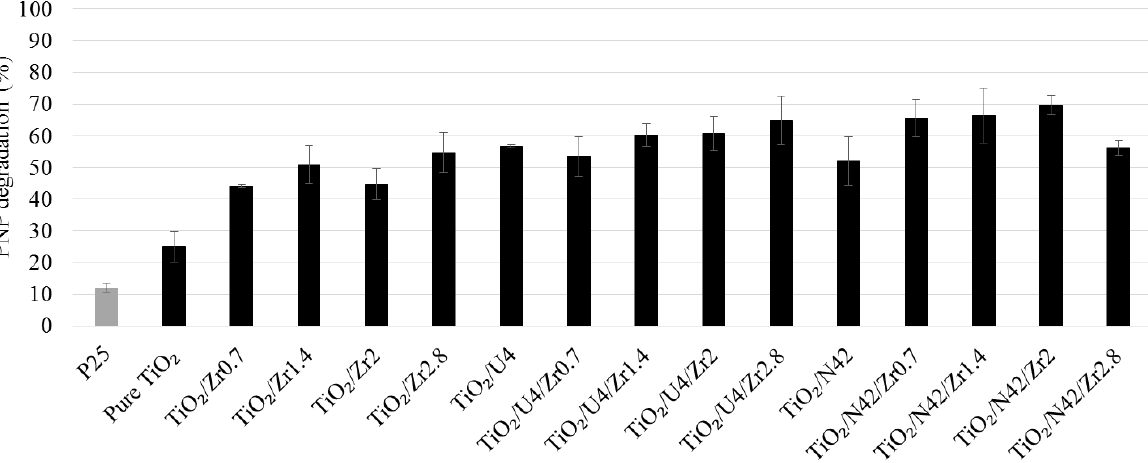
Figure 9. PNP degradation percentage for all the samples under visible light after 24 h of illumination.